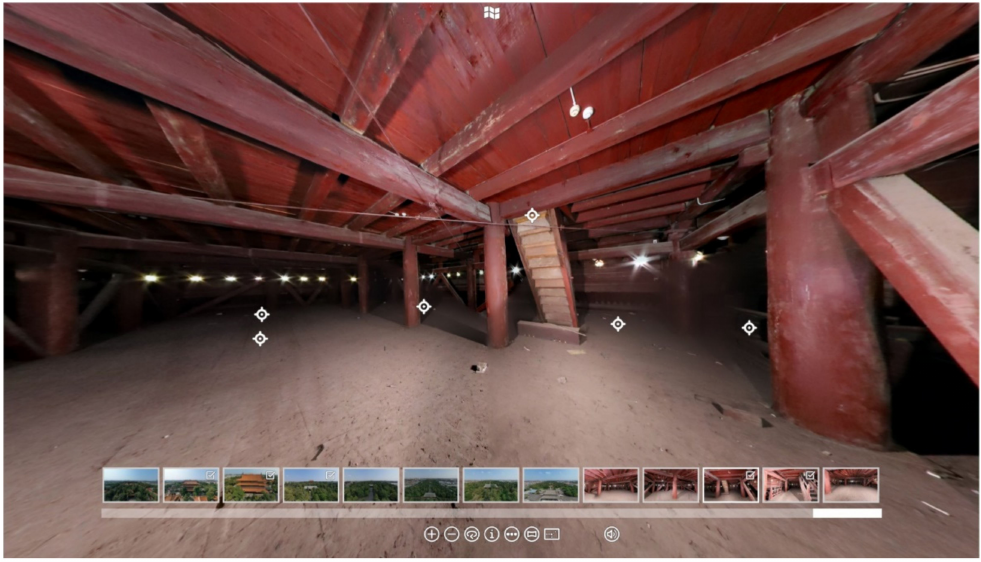
Figure 6. Panorama photo of the